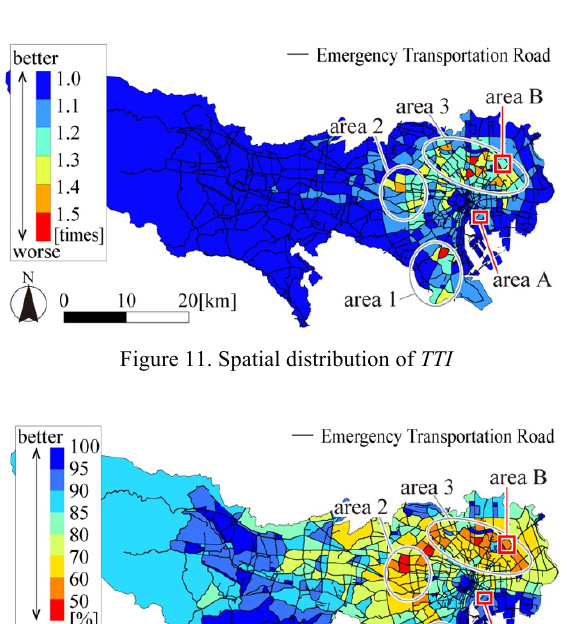
Figure 10. Spatial distribution of LA